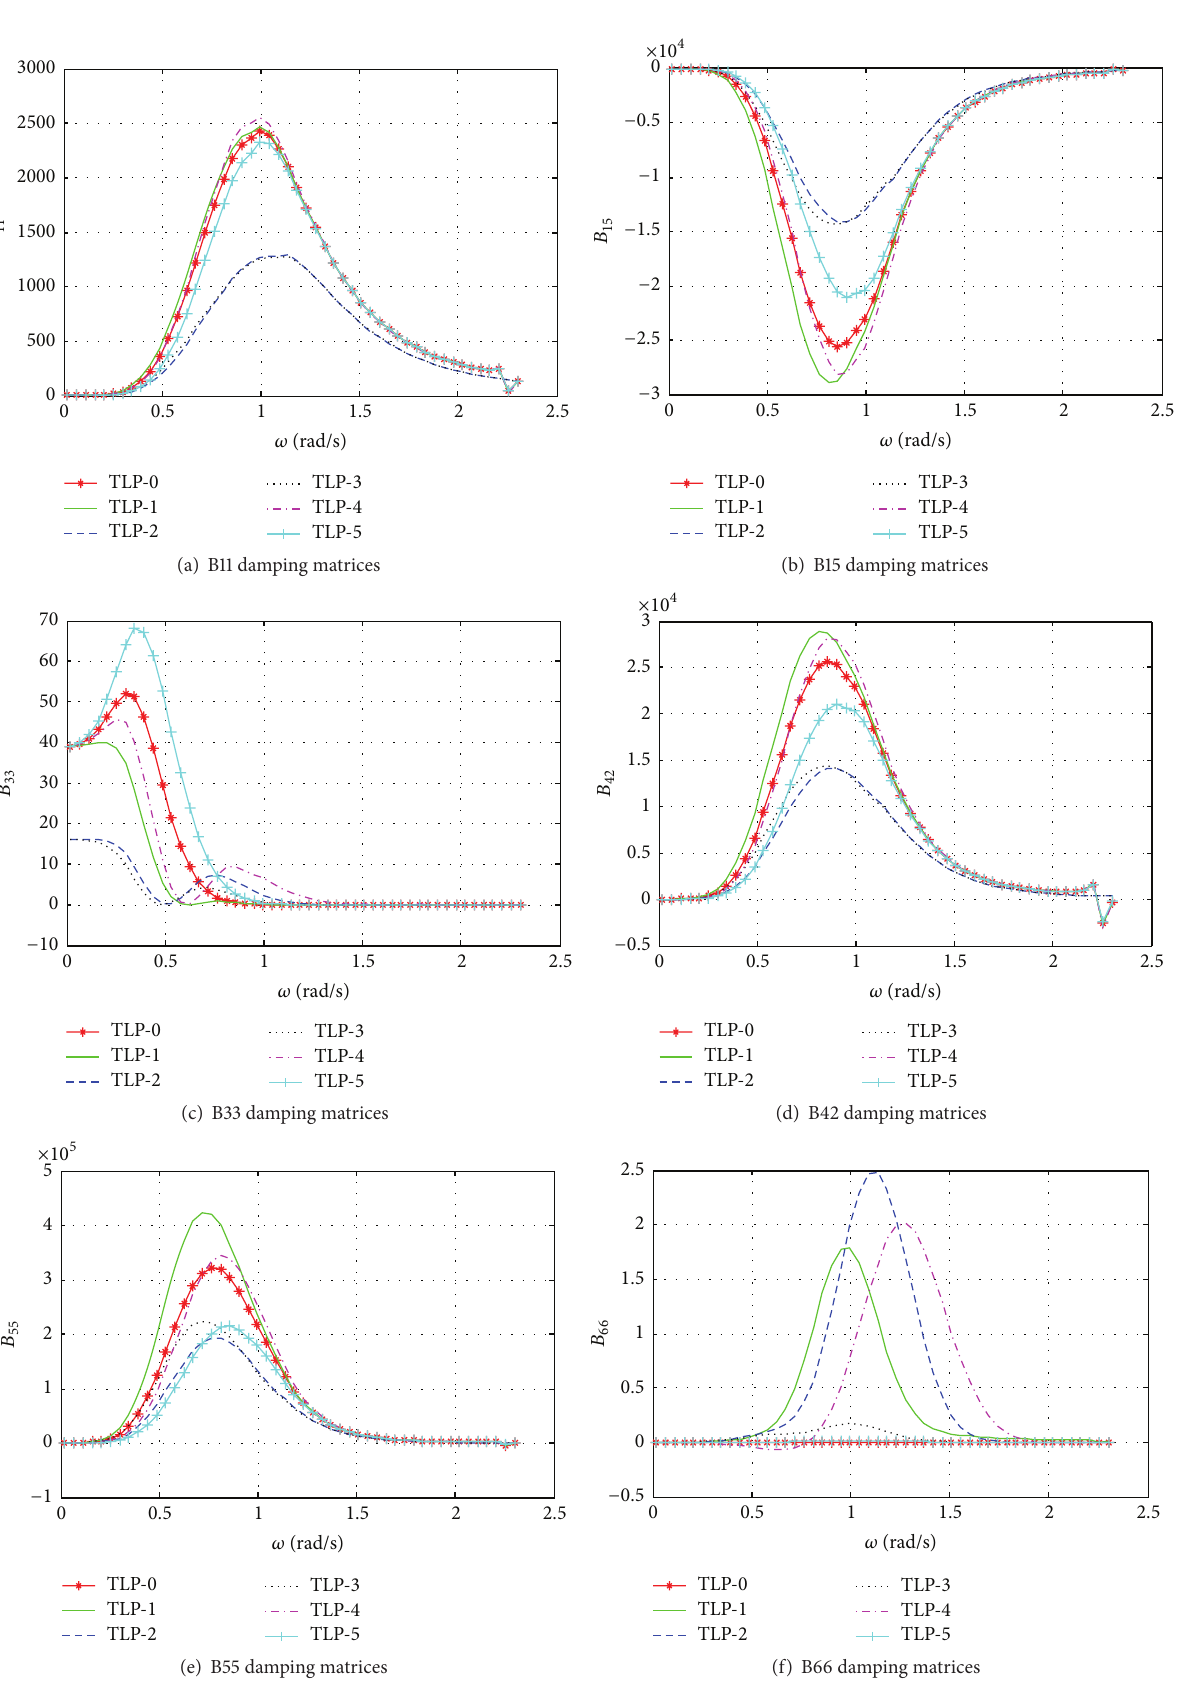
Figure 7: Damping